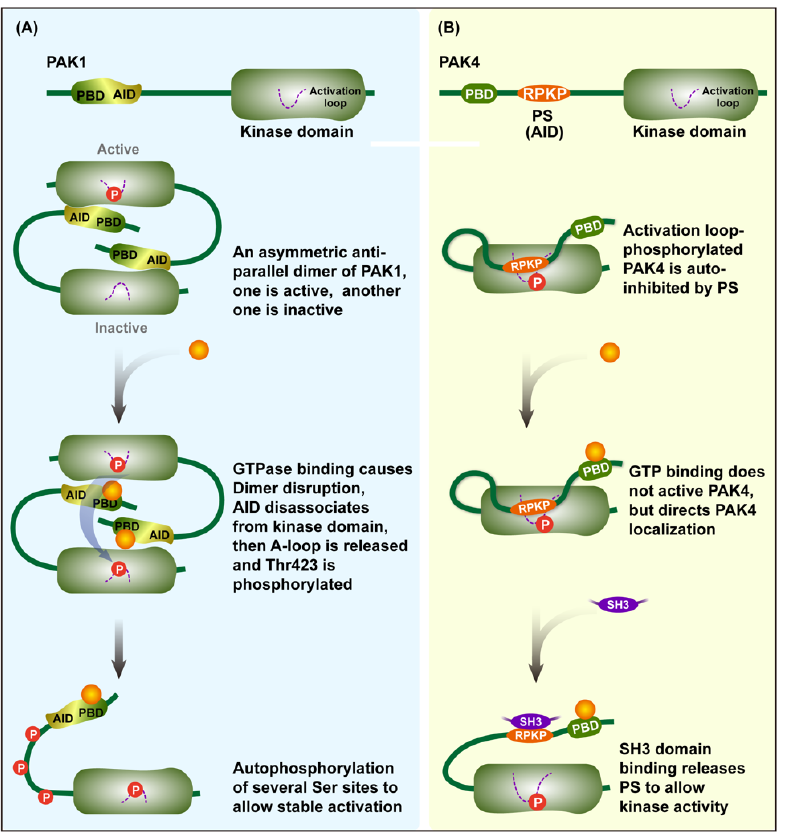
Figure 2. Activation model for Group I/II PAKs. ( A ) Representative PAK1 activation of group I. The AID of PAK1, which partially overlaps with the PBD, binds to the kinase domain of another PAK1 to form an antiparallel dimer. Binding of GTPase to PBD results in dissociation of AID from the kinase domain, active PAK1 phosphorylates the activation loop of inactive PAK1, and further, several Ser sites are phosphorylated to allow stable activity of PAK1. ( B ) Representative PAK4 activation of group II. PS binds to the kinase domain of PAK4 itself to inhibit the kinase activity, and further binding of GTPase does not release the activity of PAK4 but directs its localization in the cell. On this basis, the binding of SH3 domain to PS releases the kinase activity of PAK4. The red circle with the letter P indicates phosphorylating modification.